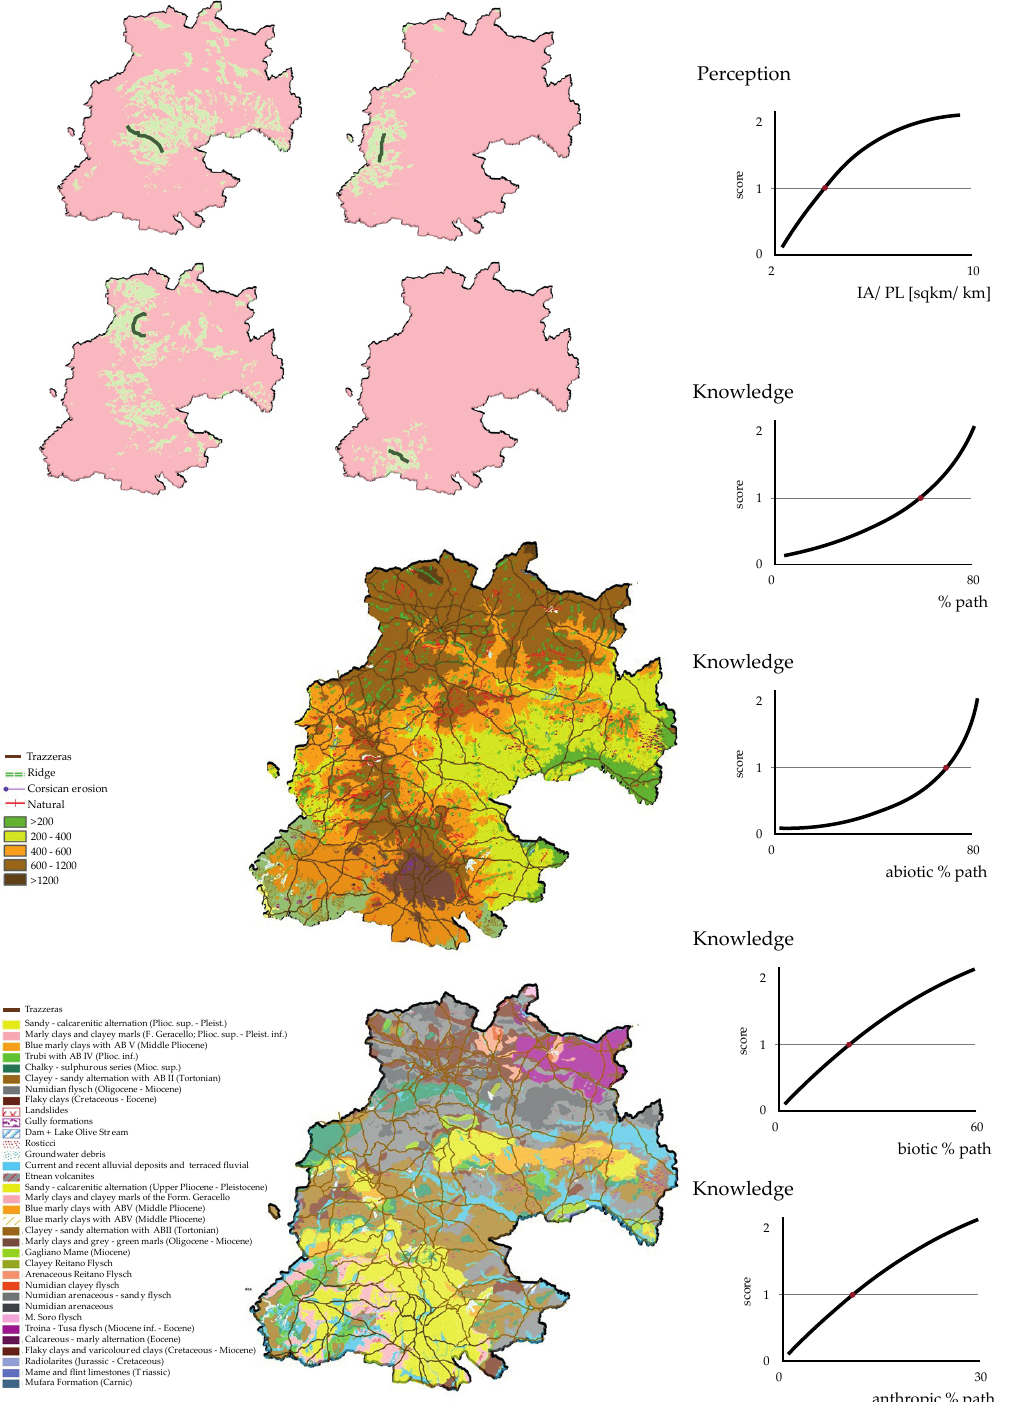
Figure 11. Critical values. Mapping and value functions.